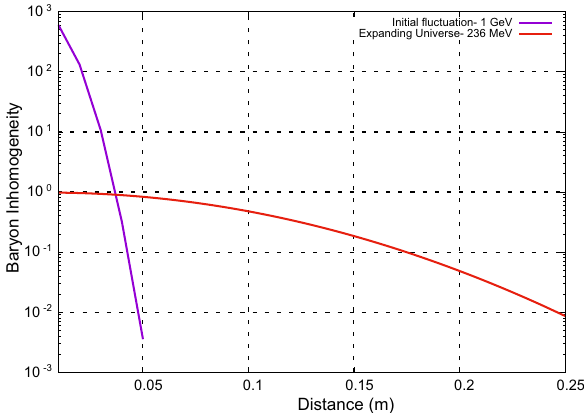
Fig. 4 The decay of the fluctuation is shown in log scale between 1 GeV and 236 MeV for a plasma where a quark is moving through a sea of electrons